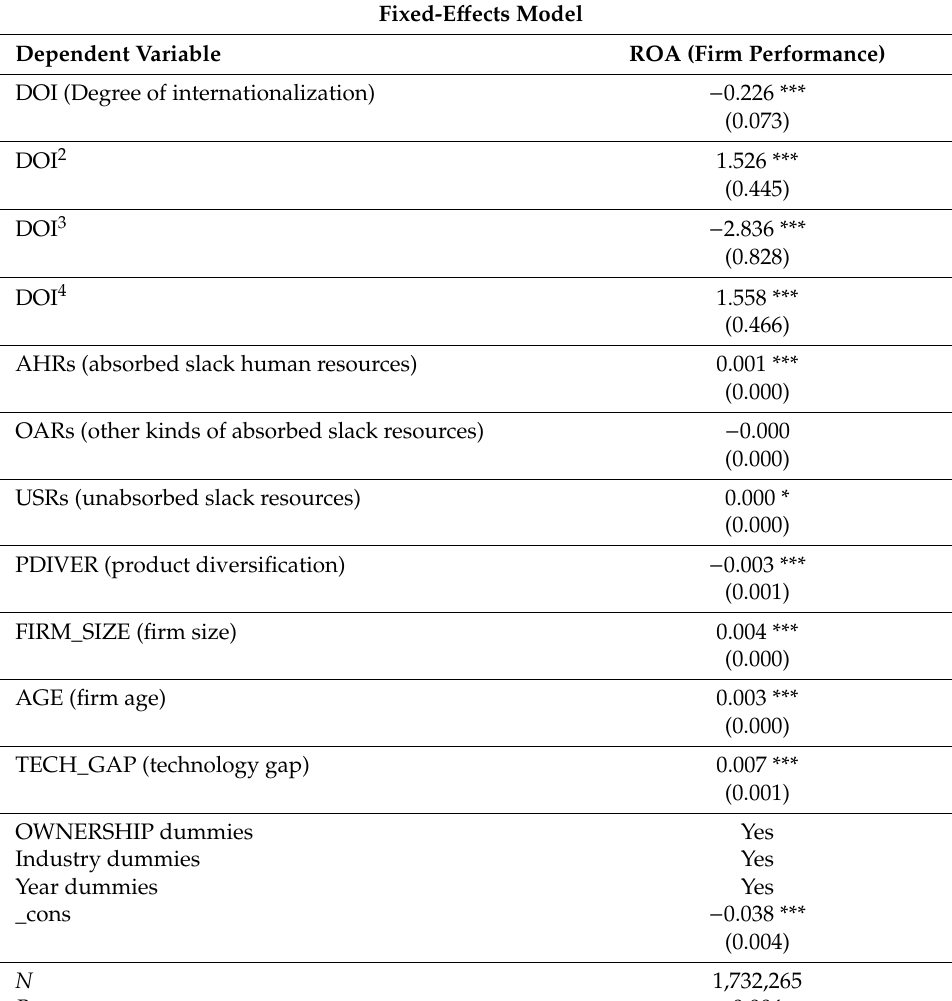
Table 3. The relationship between DOI and firm